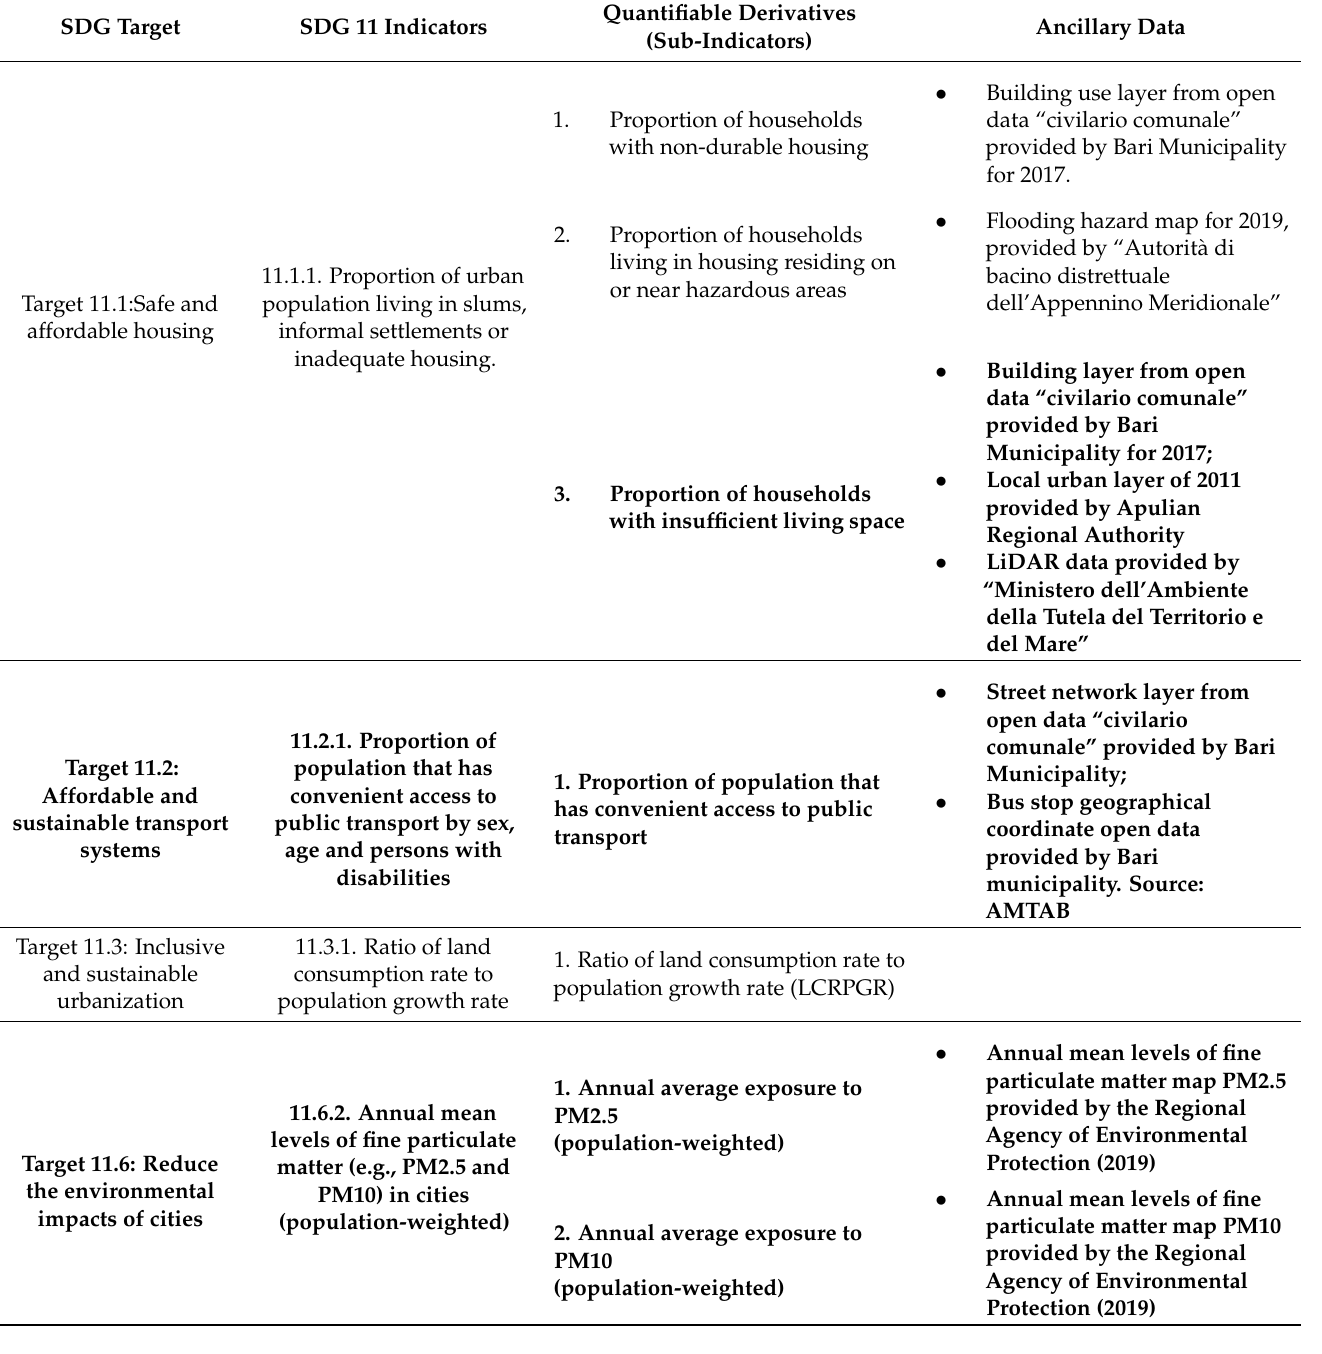
Table 4. List of ancillary data needed to evaluate SDG 11 indicators at intra-urban scale. bold format is used to identify the new indicators